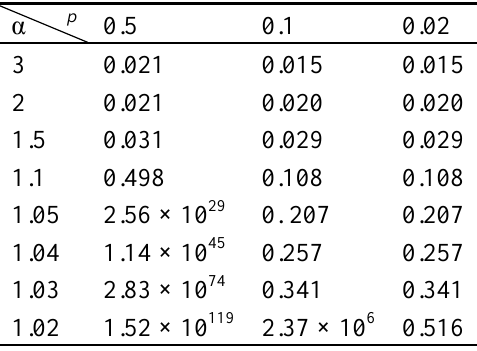
Table 4. Sample l p averages calculated by Algorithm 1 with window size 2 q + 1 = 25 for 2000-point data set from Distribution